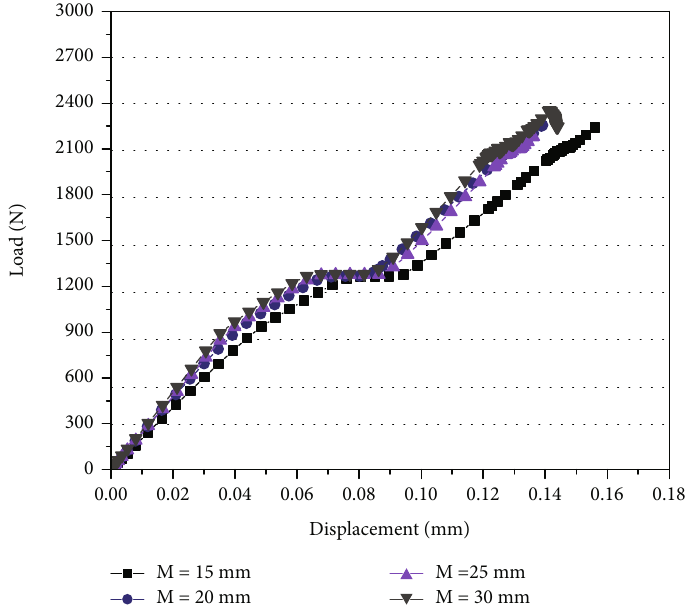
Figure 11: Load – displacement relationships for the C/SiC composite and superalloy double bolted joints under various levels of plate margin distance at 750 ° C.